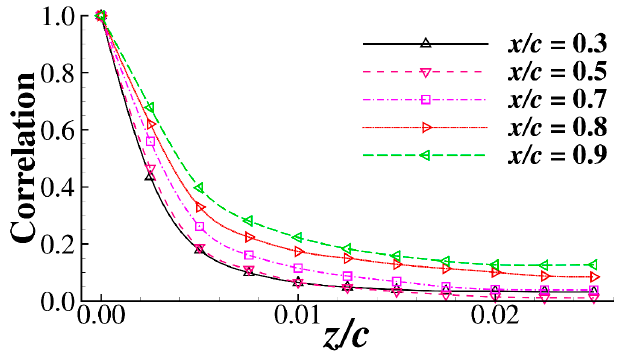
Figure 8. Spanwise autocorrelation at several streamwise locations.